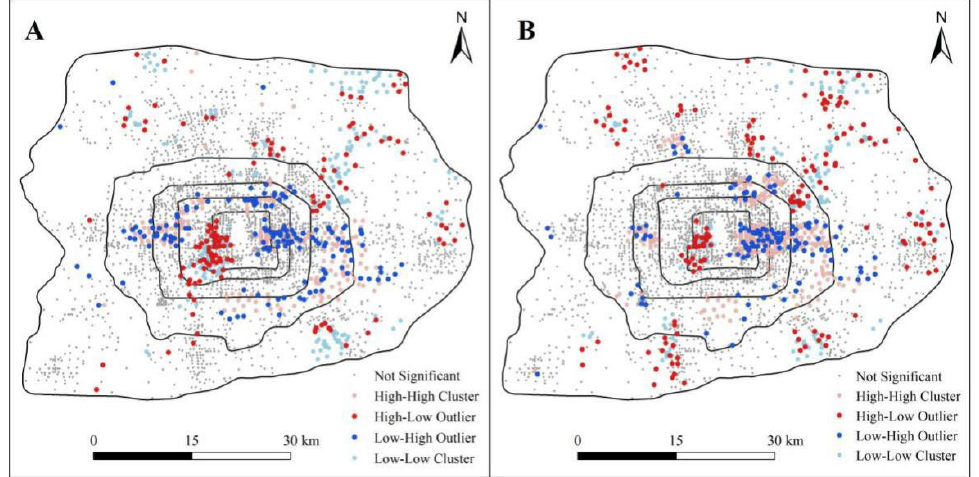
Figure 8. LISA cluster diagram of entropy index ( A ) and type number index ( B ).